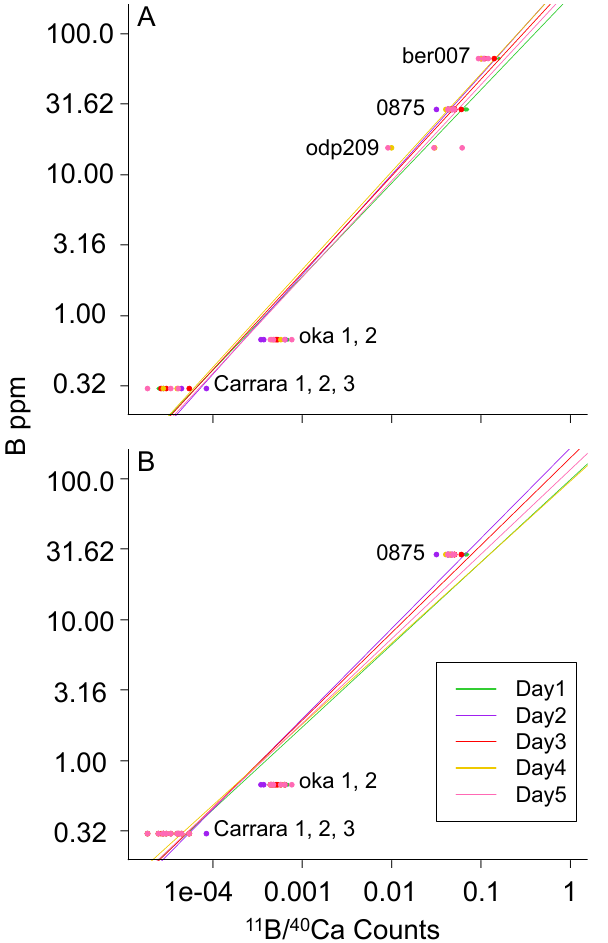
Fig. 4. Calibration curves shown on a log 10 scale. (A) Calibration curve including all standards measured on all days. (B) Working calibration curve, excluding ber007 and odp209. In panels (A) and (B) : Day 1 shown in green; Day 2, purple; Day 3, red; Day 4, gold; and Day 5, pink.